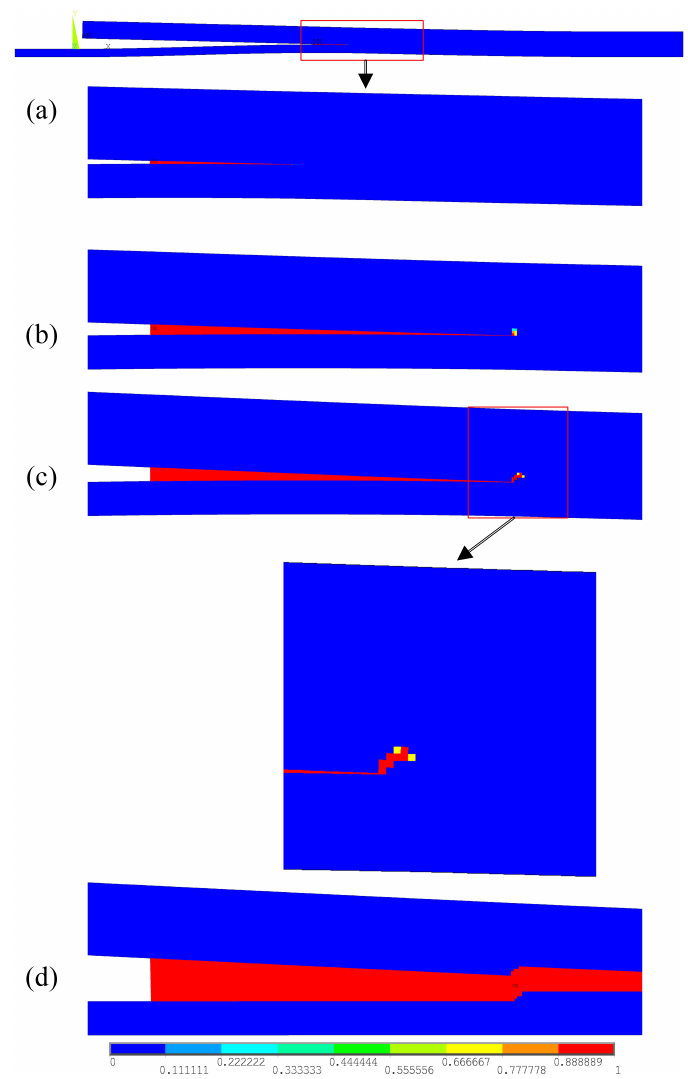
Figure 8. Contour plots of the damage variable at various load levels: ( a ) at the initial delamination propagation; ( b ) at the moment of starting migration; ( c ) at the matrix cracking; ( d ) at the load dropping after